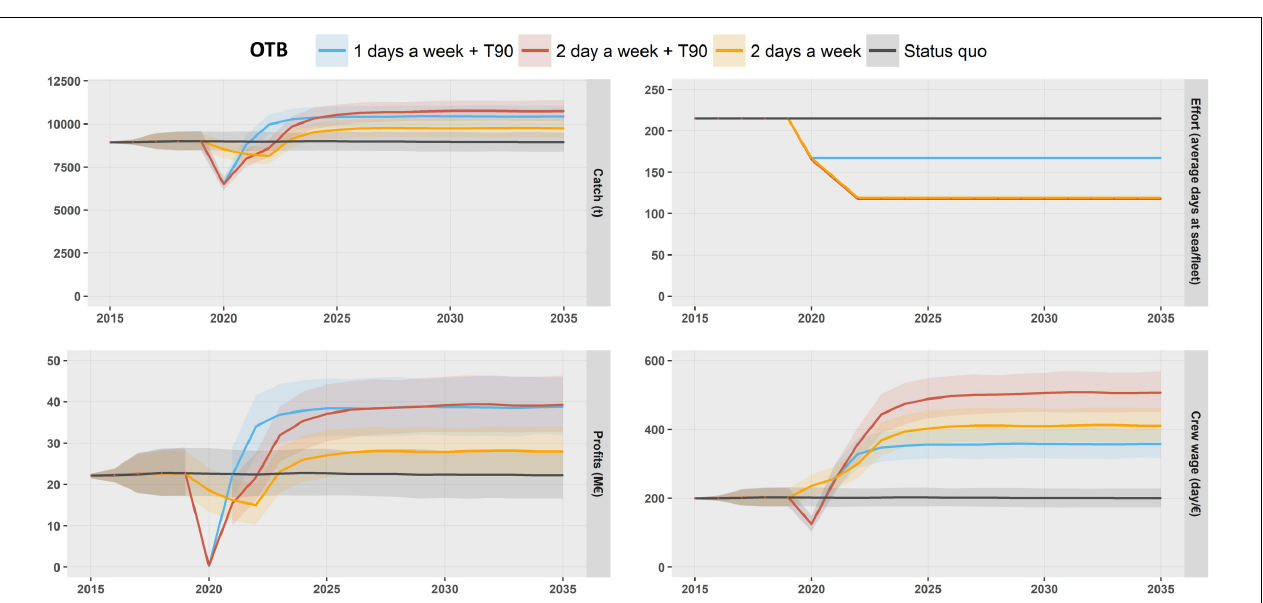
FIGURE 10 | Results of the bioeconomic model of catch (t), effort (average days at sea), profits (M€), and crew wage (€/day) for the trawler fleet (OTB) under Scenario 0: status quo ; Scenario 6: 40% effort reduction; Scenario 7: selectivity change plus 20% effort reduction; and Scenario 8: selectivity change plus 40% effort